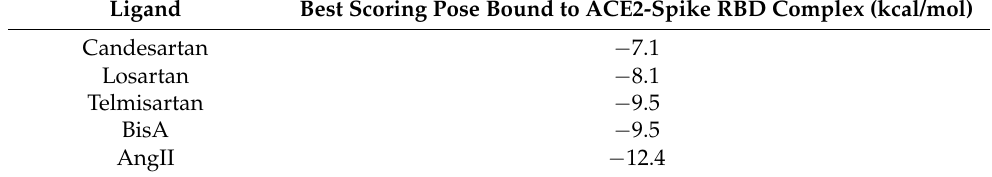
Table 1. Computed binding energies (in kcal/mol) of AngII and sartans on S-protein RBD-ACE2 complex. The higher the negative number the higher the binding energy. Binding energies and affinity constants should be viewed in relative terms—they highlight differences between ligands and do not account for entropy